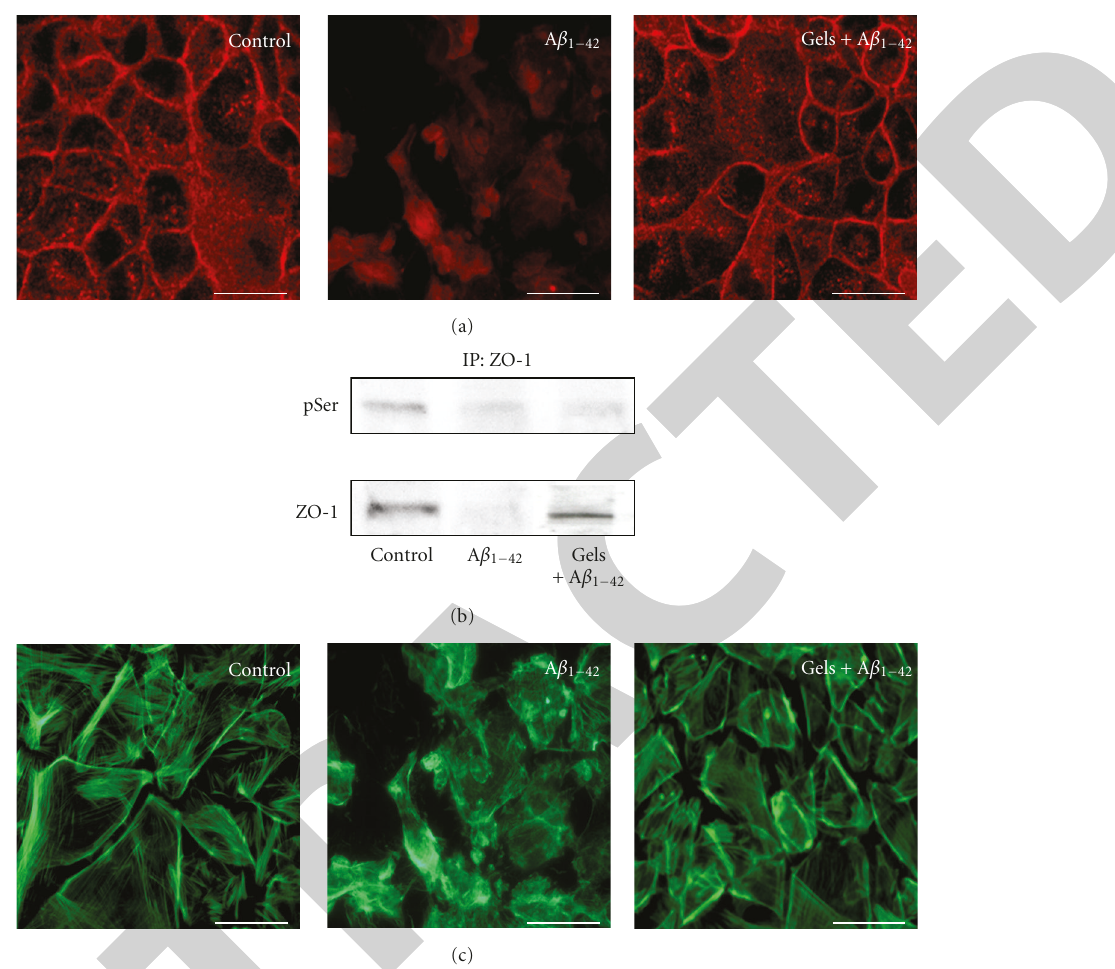
Figure 2: Secreted gelsolin inhibits A β -induced disruption on choroid plexus epithelial cell cytoskeleton. (a) Representative confocal images of choroid plexus confluent monolayer labeled with anti-ZO-1 antibody. Under control conditions, ZO-1 immunostaining is distributed along the plasma membrane. In contrast, after exposure to A β 1–42 for 48 hours, a disruption of the plasma membrane pattern of ZO-1 was observed, resulting in increased cytoplasmic localization. Note the ability of gelsolin treatment to prevent this A β -induced alteration in ZO-1 pattern. ( n = 3). (b) A β 1–42 treatment resulted in increased serine phosphorylation of ZO-1 and decreased ZO-1 expression in choroid plexus epithelial cells. Gelsolin coadministration markedly attenuated A β 1–42 alteration in ZO-1 ( n = 3). (c) BIODIPY FL phallacidin staining of choroid plexus epithelial cells showed a disruption of the actin cytoskeleton after treatment with A β 1–42 for 48 hours, and reversion when gelsolin was simultaneously added. Magnification: × 40. Scale bars = 10 μ